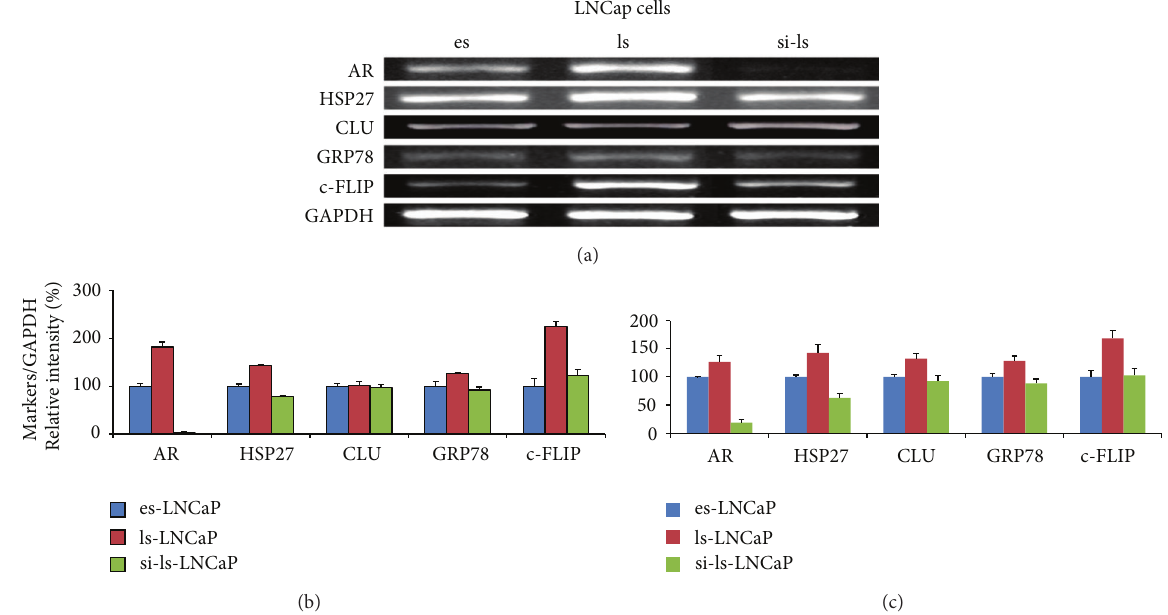
Figure 4: Electrophoretogram and its densitogram of conventional RT-PCR/real-time PCR product for androgen receptor, HSP27, CLU, GRP78, and c-FLIP expression at the es-, ls-, and the si-ls-LNCaP cells.